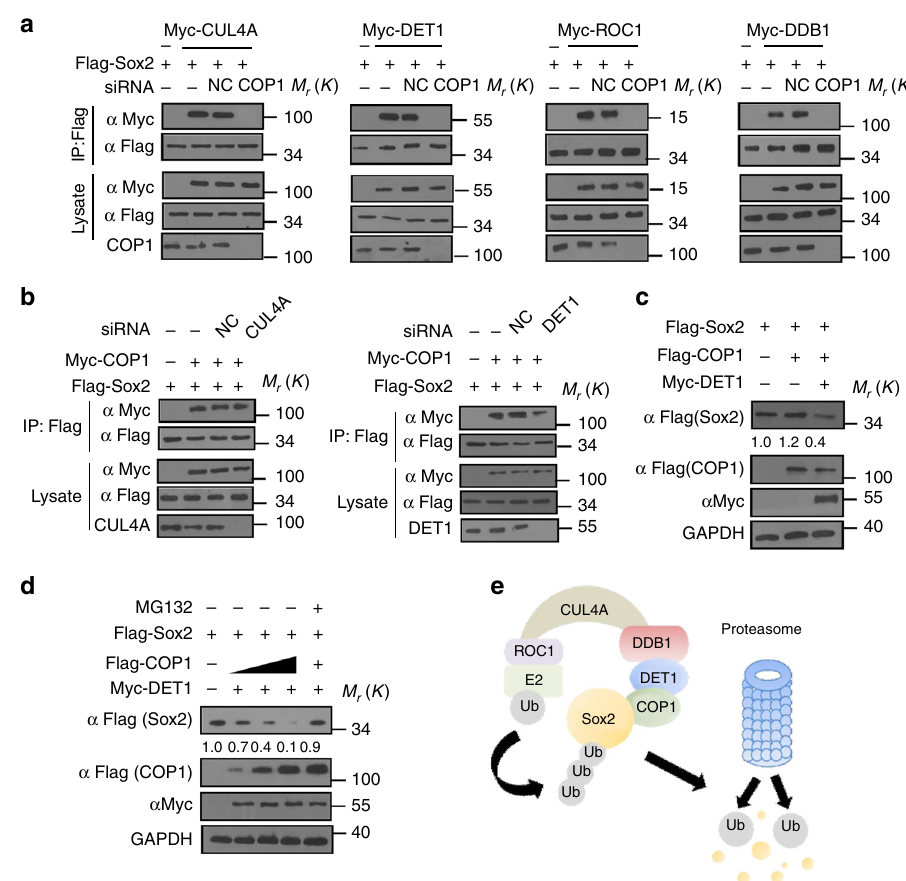
Fig. 3 COP1 interacts with Sox2 directly. a Cells were transfected with indicated constructs and siRNA. Flag-Sox2 was immunoprecipated with anti-Flag and immunoblotted with anti-Myc. b HEK293T cells were transfected with indicated constructs and siRNA, and Sox2 was immunoprecipated with anti-Flag and immunoblotted with anti-Myc. c HEK293T cells were transfected with indicated constructs and western blot was performed to measure the expression of Flag-Sox2, Flag-COP1, and Myc-DET1. d Increasing amounts of Flag-COP1 were co-transfected together with Flag-Sox2 and DET1 into HEK293T cells and ectopic Flag-Sox2 expression was detected. e The predicted work model of CUL4A DET1-COP1 for Sox2 degradation. The representative images are shown from three independent experiments. Unprocessed original scans of blots are shown in Supplementary Fig.